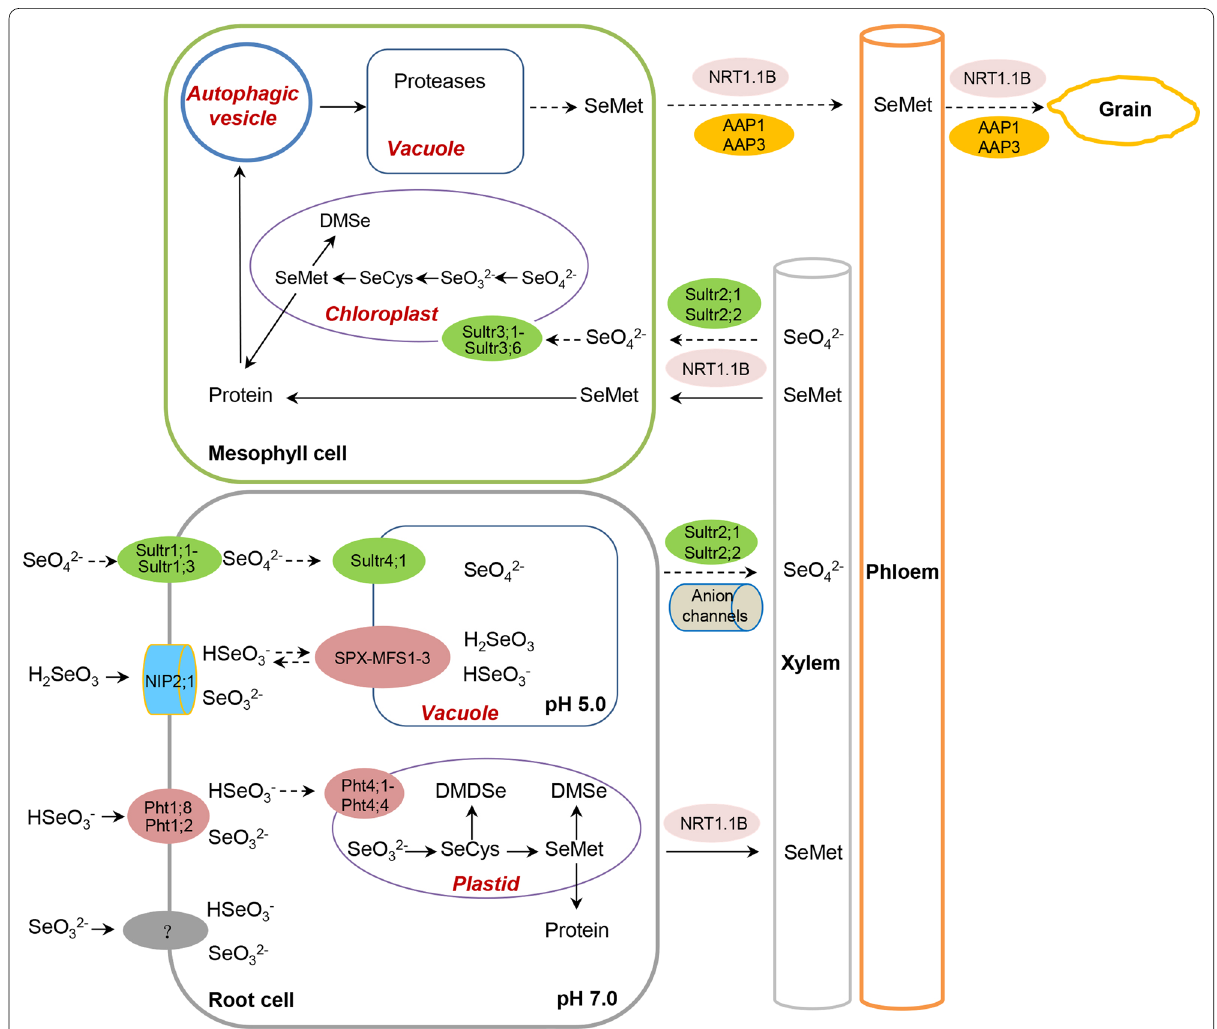
Fig. 1 The uptake, transport, subcellular distribution, retranslocation, and volatilization of Se in rice. Selenate is taken up through Sultr1;1, Sultr1;2, and Sultr1;3, located in the root epidermal cell membrane, a small part of selenate enters the vacuole through Sultr4;1 located in the tonoplast, and most of it is transported to the leaves through Sultr2;1 and Sultr2;2 located in the parenchyma cell membrane of the xylem, finally enters the chloroplast through Sultr3;1, Sultr3;2, Sultr3;3, Sultr3;4, Sultr3;5, and Sultr3;6 located in the chloroplast membrane, where they are converted into SeCys and SeMet to participate in protein synthesis in a non-specific manner, and can also be further converted into DMSe and volatilized. Rice roots can take up HSeO 3 − and H 2 SeO 3 through OsPht1;2 (OsPT2) and OsNIP2;1, respectively. After selenite enters the cytoplasm, it mainly exists in the form of HSeO 3 − and SeO 32 − ; part of the selenite enters the vacuole through OsSPX-MFS1/3 and OsVPE1/OsVPE2 located in the tonoplast. Selenite mainly exists in the form of H 2 SeO 3 and HSeO 3 − in the vacuole; most of it is transported to the plastid by OsPHT4;1-OsPHT4;4 and OsPHT2;1 and converted into SeCys and SeMet, and then participate in protein synthesis non-specifically, and can also be further converted into DMSe and volatilizes. Part of SeMet is transported to shoots through NRT1.1B and participates in protein synthesis. In senescent leaves, protein is encapsulated in autophagic vesicles and transported to vacuoles, degraded into SeMet by proteases, and transported to rice grains through OsAAP1, OsAAP3, and OsNRT1.1B. Sulfate transporters, Solid lines correspond to identified transporters and dashed lines correspond to potential